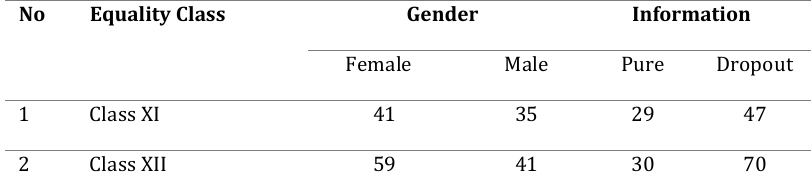
Table 1 Demographic Data on Research